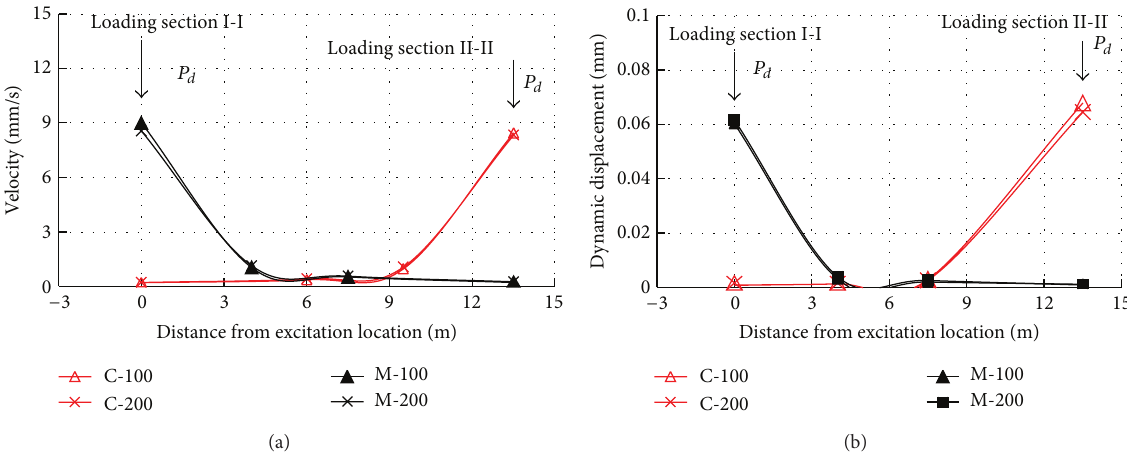
Figure 15: Distribution of vertical velocity (a) and dynamic displacement (b) of the low subgrade beneath the foundation plate along the longitudinal subgrade.